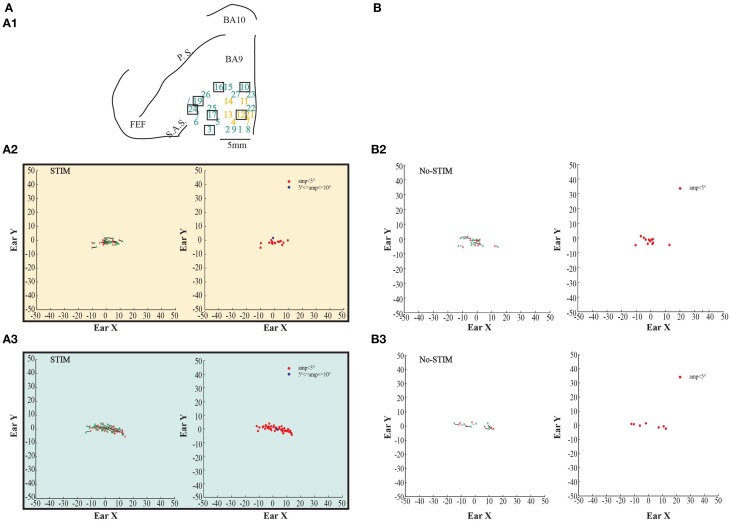
Example of fixed-vector ear movements. (A) The figures show data from Monkey S. For further information on the figures the reader should refer to the legend of Figure 3.